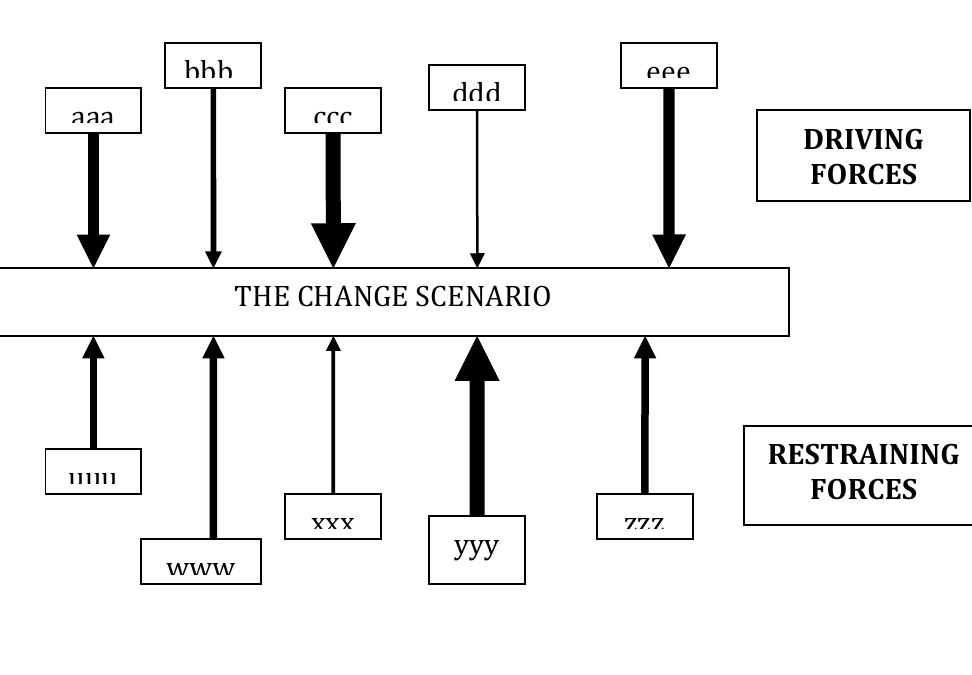
Figure 1 . The force field diagram